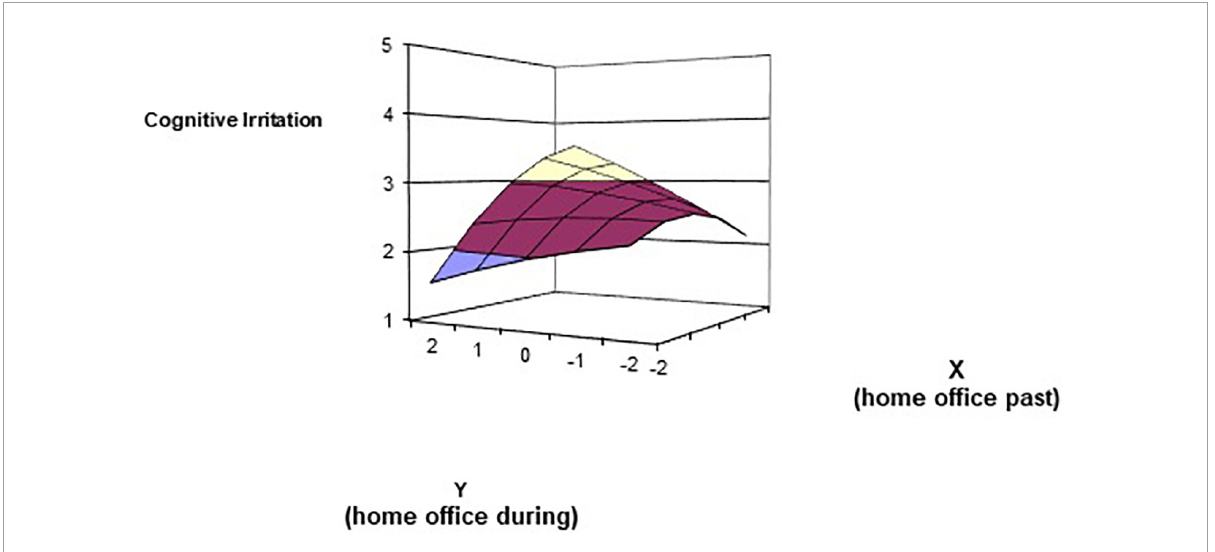
FIGURE1 Response surface analysis of working from home prior to (X) and during (Y) the pandemic spring of 2020 in relation to cognitive irritation. Germany, Czechia, and Italy were included as dummy variables (1 = yes , 0 = no ); Slovakia served as the reference country.